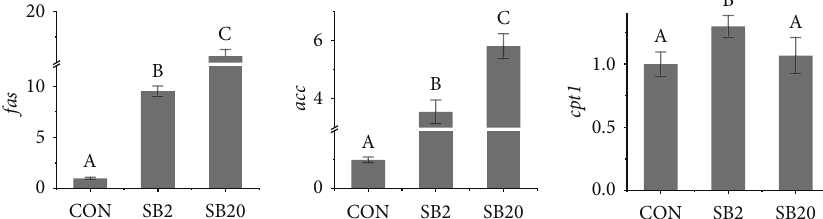
Figure 3: E ff ects of two dosages of sodium butyrate on the relative expression of liver lipid synthesis-related genes in largemouth bass, Micropterus salmoides. fas : encode fatty acid synthase; acc : encode acetyl-CoA carboxylase; cpt1 : encode carnitine palmityl transferase 1. Di ff erent letters above the bars represent signi fi cant di ff erences ( P < 0 : 05 , n = 3